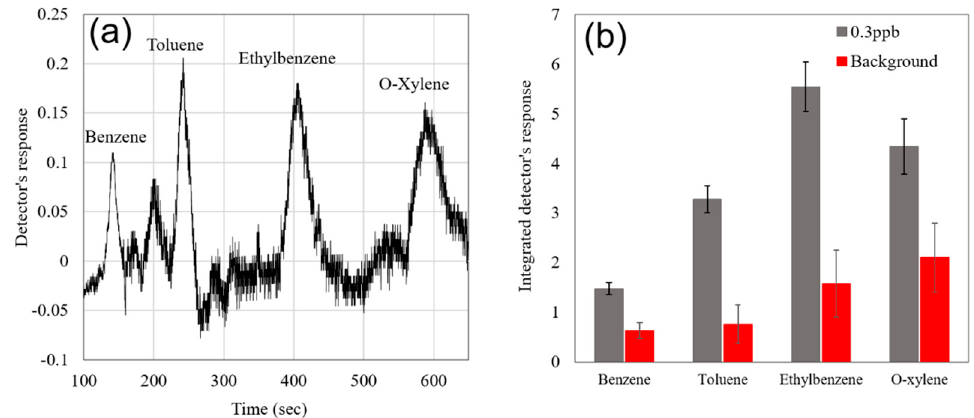
Figure 10. ( a ) Gas chromatogram of 0.3 ppb of the BTEX mixture; ( b ) integrated detector’s response to 0.3 ppb of BTEX mixture and integrated GC background signal.